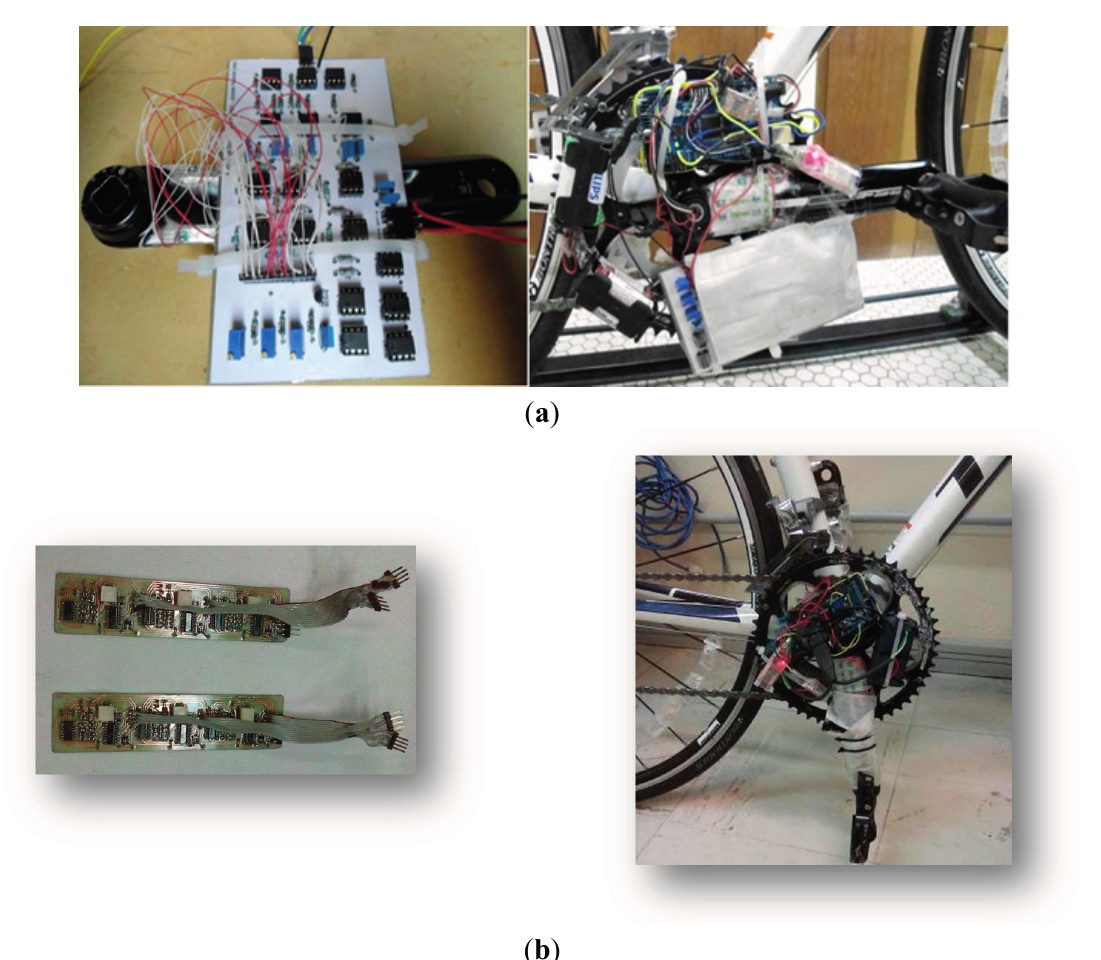
Figure 8. Force platform assembled: ( a ) first prototype and ( b ) final prototype (111.13 × 26.67